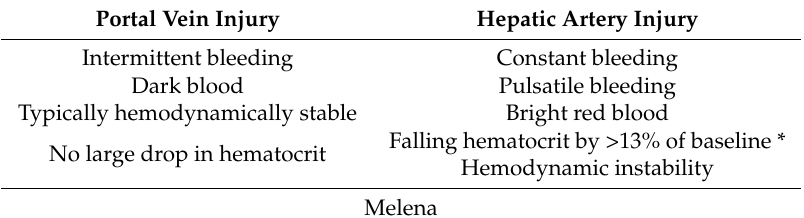
Table 1. Clinical signs of portal vein versus hepatic artery injury, noting that significant overlap may be seen in the clinical picture. * A drop in baseline hematocrit by 13% or more was 94% specific for hepatic artery injury but only 10% sensitive [12]. If portal vein injury is suspected, the best imaging modality to confirm this is a pullback cholangiogram. If hepatic artery injury is suspected, angiogram should be performed without delay. If initial angiogram is negative, the biliary drain should be removed over a wire, a maneuver which has been shown to increase sensitivity of the angiogram 1.7 times fold [29]. Portal Vein Injury